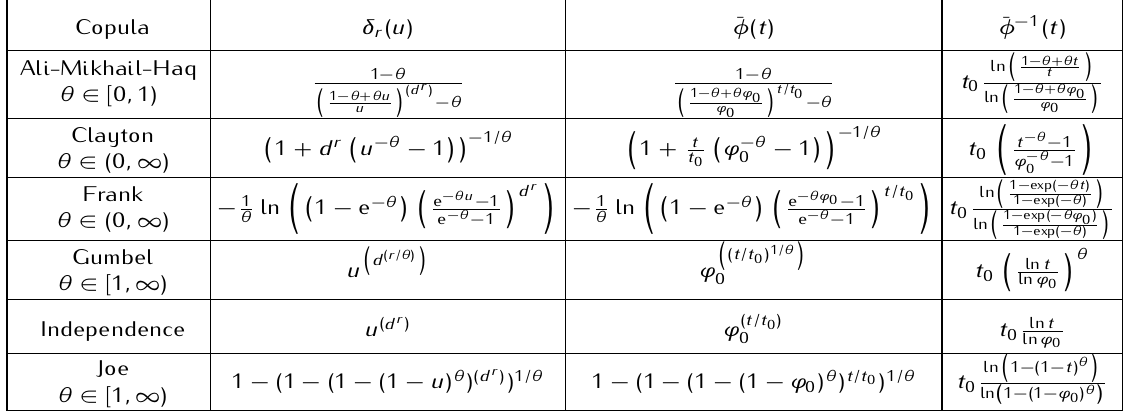
Table 2. Standardized generators ¯ φ , such that ¯ φ ( t 0 ) = φ 0 , their associated inverses and theoretical self-nested diagonals in the case of most popular Archimedean families of copulas.